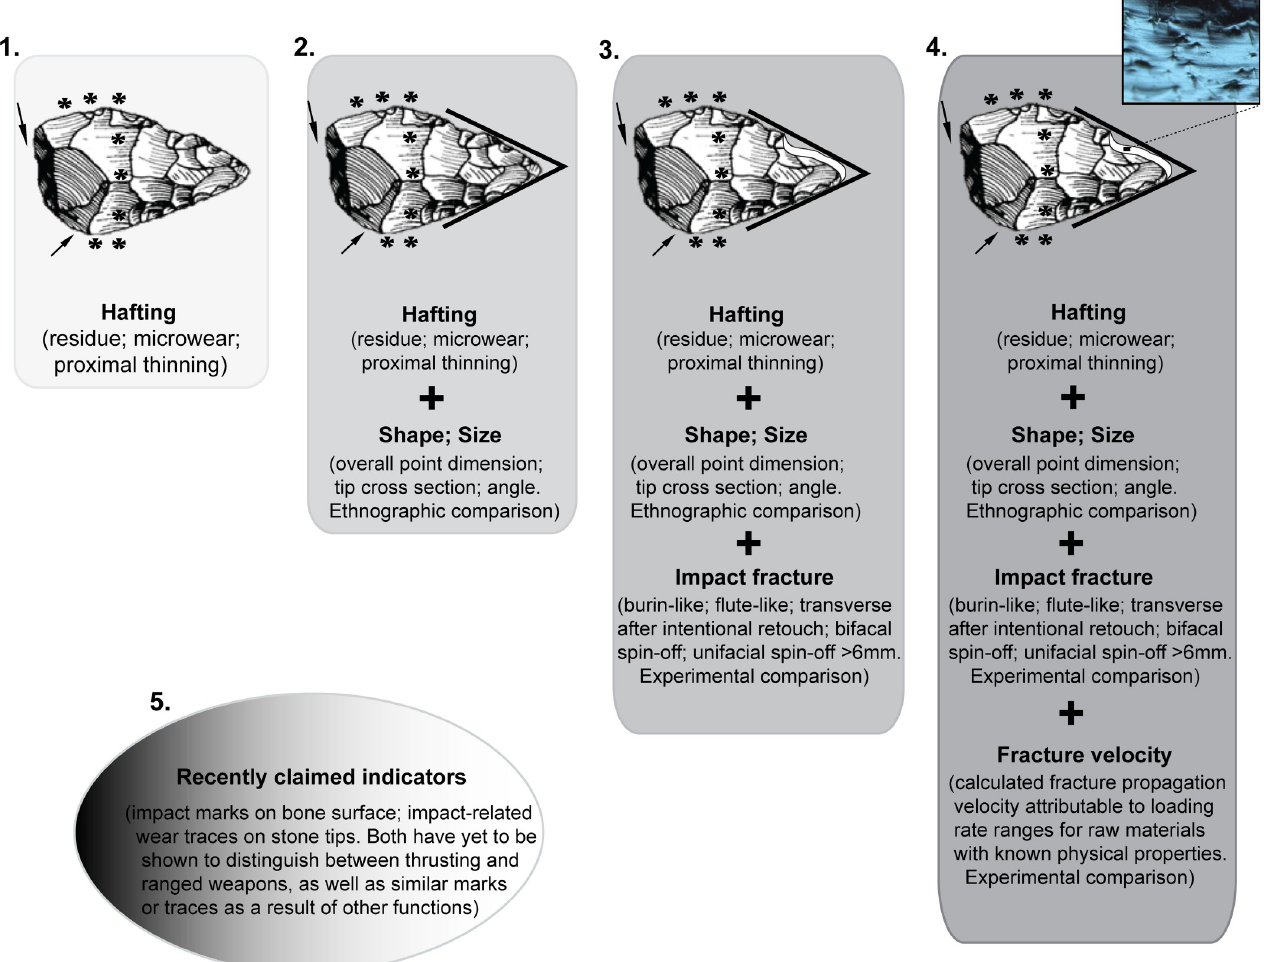
Fig 1. A schematic representation of evidence and methodology widely used for determining prehistoric projectile weaponry. Strength of evidence increases from 1 (i.e. hafting) to 4 . Larger ethnographic datasets and more experiments are still needed to test these indices further. Impact fractures considered diagnostic of projectiles do not distinguish between simple and complex projectiles; more work should explore this possibility. Methods depicted in 5 require adequate demonstration of applicability. In all approaches, the claim for projectile use should effectively eliminate potential use as thrusting spears, or even as hafted knives, barbed clubs,